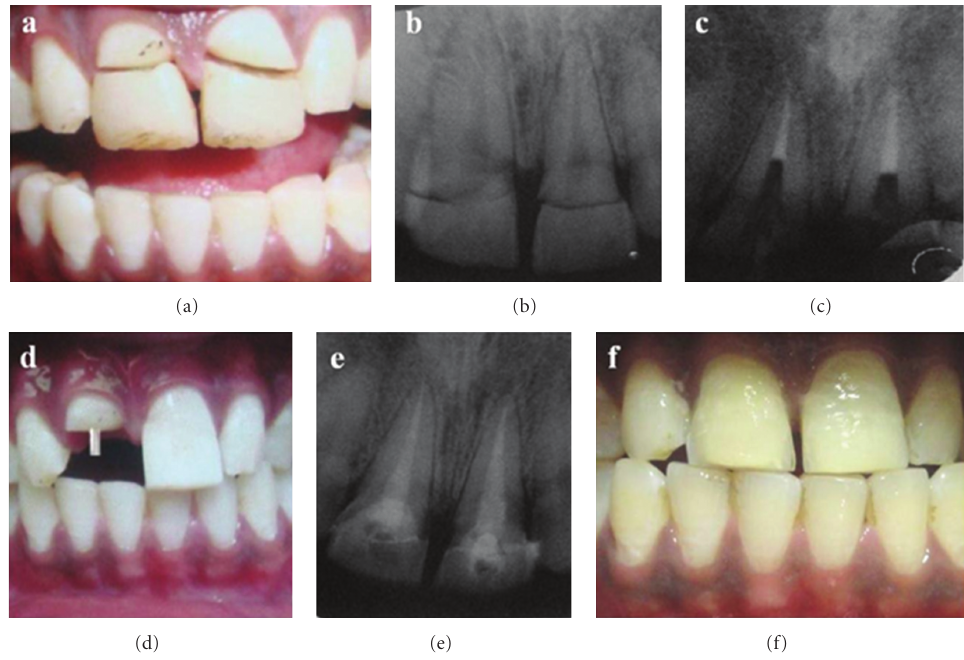
Figure 1: Reattachment of fractured tooth segments using a prefabricated fiber post. (a) Clinical appearance of the patient, (b) preoperative radiograph, (c) sectional obturation of the root canals, (d) fiber post luted in the root canal with 2 mm of the retentive part of the post outside the chamber, (e) postoperative radiograph, and (f) clinical view after segments reattachment.